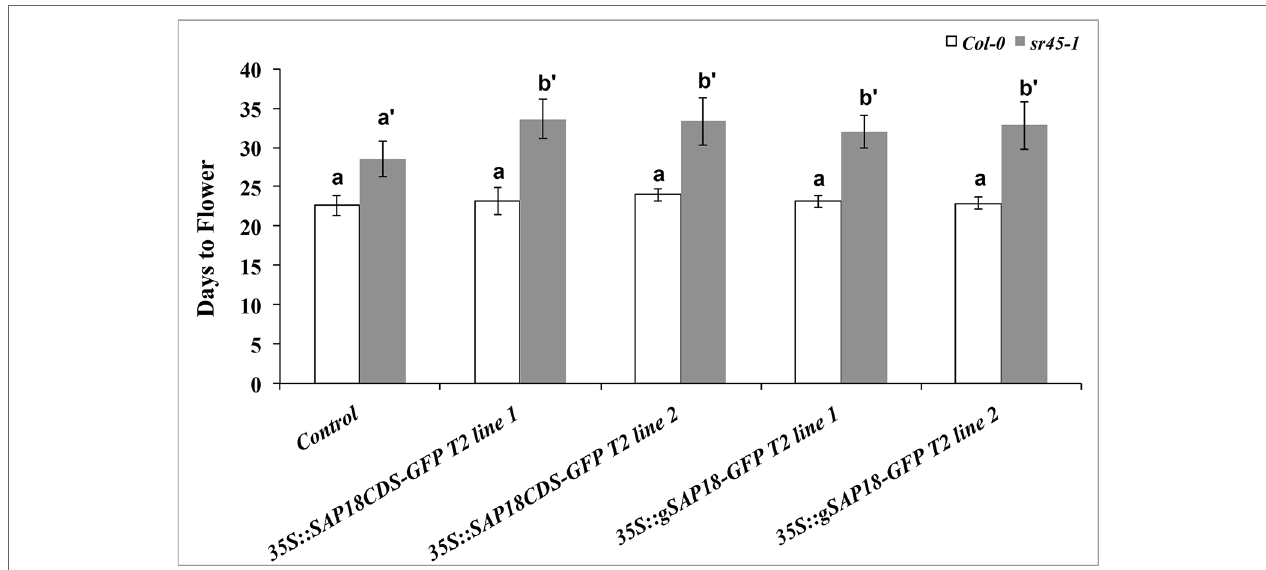
FIGURE 5 | A comparison of flowering time among different genotypes grown under long-day condition (L:D = 16:8). The number of days before bolting is used to indicate days to flower. Transgenic lines were compared with their corresponding controls (Col-0 or sr45-1 ), respectively. Kruskal-Wallis test followed by post- hoc Dunn test was used for statistical analysis. Benjamini-Hochberg FDR method was used to calculate adjusted p- values. Letter a represents statistical level of Col-0 and its transgenic lines; letters a’ and b’ represent different levels of statistical significance for sr45-1 and its transgenic lines. n = 10. FDR < 0.05. Error bars represent standard